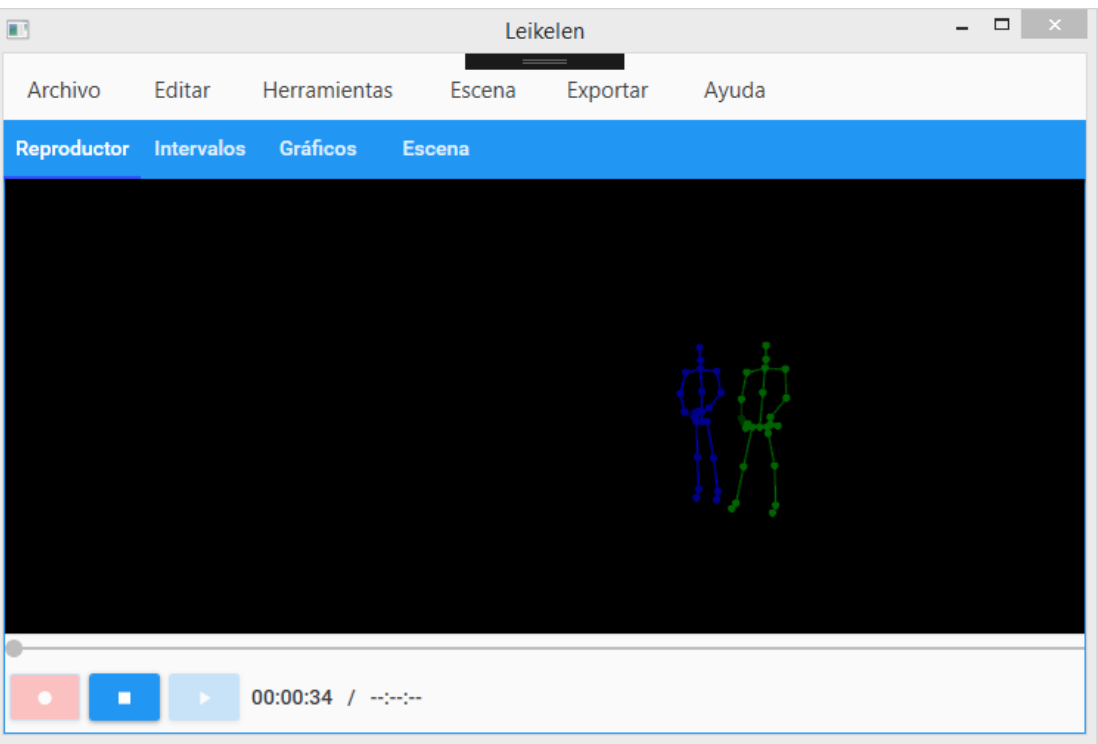
Figure 3. Lelikelen application screen showing the skeleton models of two